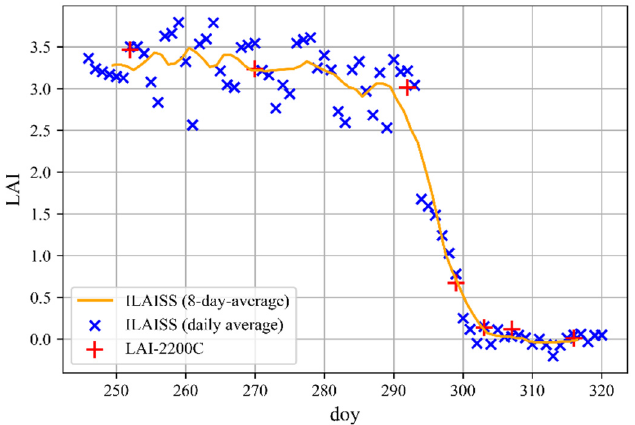
Figure 12. The LAI that was measured with the ILAISS and the LAI-2200C instrument during the 2021 campaign as a function of doy.